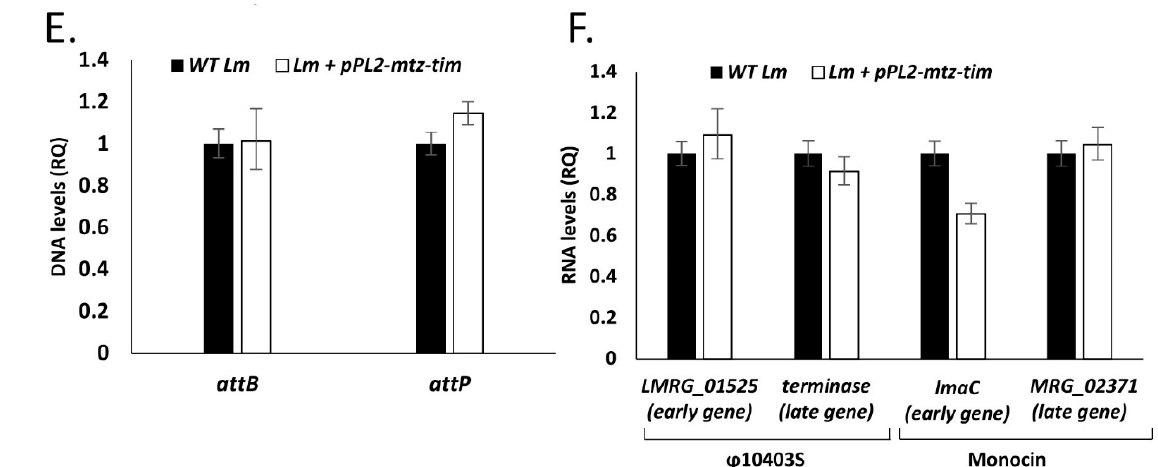
Figure 5. Ectopic expression of Mtz-Tim enhances phage-mediated lysis. ( A ) Growth analysis in BHI media of WT Lm , and WT Lm harboring pPL2 integrative plasmid expressing mtz, tim or both from inducible p tetR promoter (pPL2- mtz, pPL2- tim , and pPL2- mtz - tim respectively) with addition of MC at 37 ◦ C. ( B ) Growth analysis in BHI media of WT Lm , and WT Lm harboring pPL2 integrative plasmid expressing mtz - tim or mtz mutated at position E136A with tim from an inducible p tetR promoter (pPL2- mtz - tim and pPL2- mtz(inactive) - tim , respectively) with addition of MC at 37 ◦ C. ( C ) Growth analysis in BHI media of WT Lm , and deletion mutant lacking prophage elements ( ∆ phages ) harboring pPL2 plasmid expressing mtz-tim from an inducible p tetR promoter (pPL2- mtz-tim ) with and without addition of MC, as indicated, at 37 ◦ C. Data in A-C represent three independent experiments and error bars represent the standard deviation of triplicates. ( D ) Production of infective virions assayed as PFU in WT Lm bacteria and WT Lm harboring pPL2 integrative plasmid expressing mtz-tim from an inducible p tetR promoter (pPL2- mtz-tim ) grown at 37 ◦ C in BHI with MC for 5 h. The results are normalized to PFU of WT bacteria. The data are the mean of three independent experiments and error bars represent the standard deviation. ( E ) Phage excision and replication levels in WT Lm and WT Lm harboring pPL2 integrative plasmid expressing mtz-tim from inducible p tetR promoter (pPL2- mtz-tim ). RT-qPCR analysis of intact comK gene, representing the ϕ 10403S attB site, and the circularized phage genome, representing the attP site, performed on DNA extracted from bacteria grown at 37 ◦ C in BHI with MC for 4 h. Data presented as relative quantity (RQ), compared to the levels in WT bacteria and normalized to the levels of the rpoD gene. The data represent three independent experiments and error bars indicate a 95% confidence interval. ( F ) RT-qPCR transcriptional analysis of the indicated ϕ 10403S and monocin genes of Lm bacteria deleted for phage lysis factors and the same strain harboring pPL2 integrative plasmid expressing mtz-tim from inducible p tetR promoter (pPL2- mtz-tim ) grown at 37 ◦ C in BHI with MC for 4h. Data are presented as relative quantity (RQ), compared to the levels in WT bacteria and normalized to the levels of the rpoD gene. The data represent three independent experiments. Error bars indicate the 95% confidence